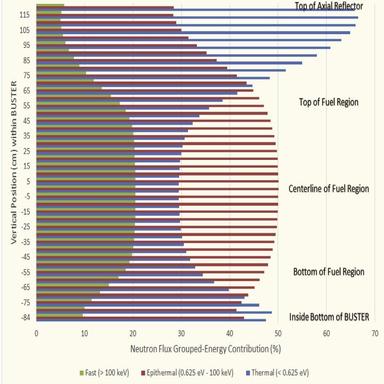
Axial Distribution of Contribution to Neutron Spectra by Energy Groups for Full-Slotted Core (300 K).